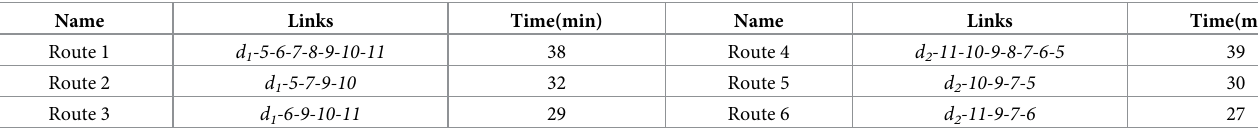
the limitation of B , the resilience index is the largest, and all affected passengers can be evacu- ated at one time. By analyzing the different resource limitations, we can also conclude that when bus resources increase up to a certain value, the indicators do not significantly change, and too much input may waste resources. However, with limited resources, the cycling strategy Table 4. The links and travel time of candidate bridging-bus routes in